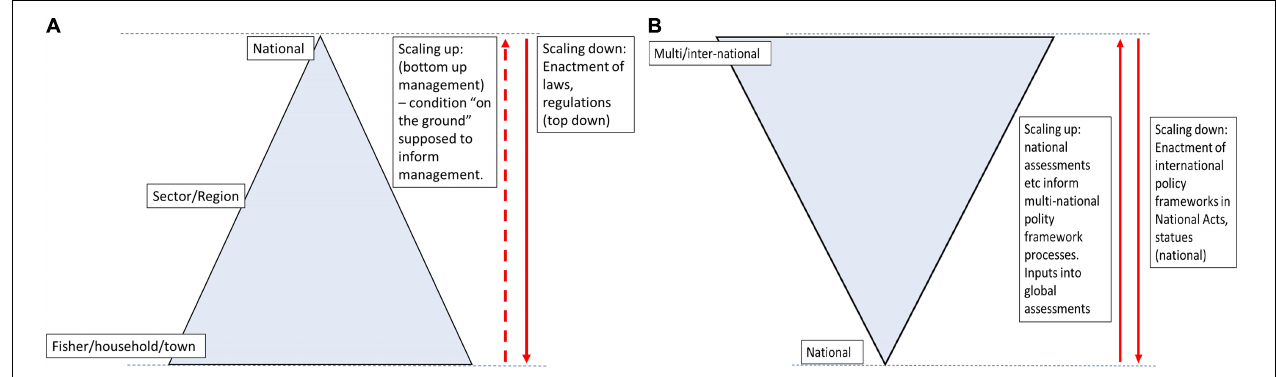
FIGURE 7 | Current pathways for scaling processes in the South African fisheries policy landscape. Fisheries management in South Africa is typically ‘top-down’ (A) With local scale interactions often not considered in policy-making decisions (indicated by broken line). Inter-, multinational policy frameworks and commitments (B) Are enacted in the government’s national policies/acts. Conversely; national assessments, concerns are integrated into the inter-multinational policy frameworks and assessments by engagement in a process which formulate such frameworks and assessments (such as IPCC, IPBES,